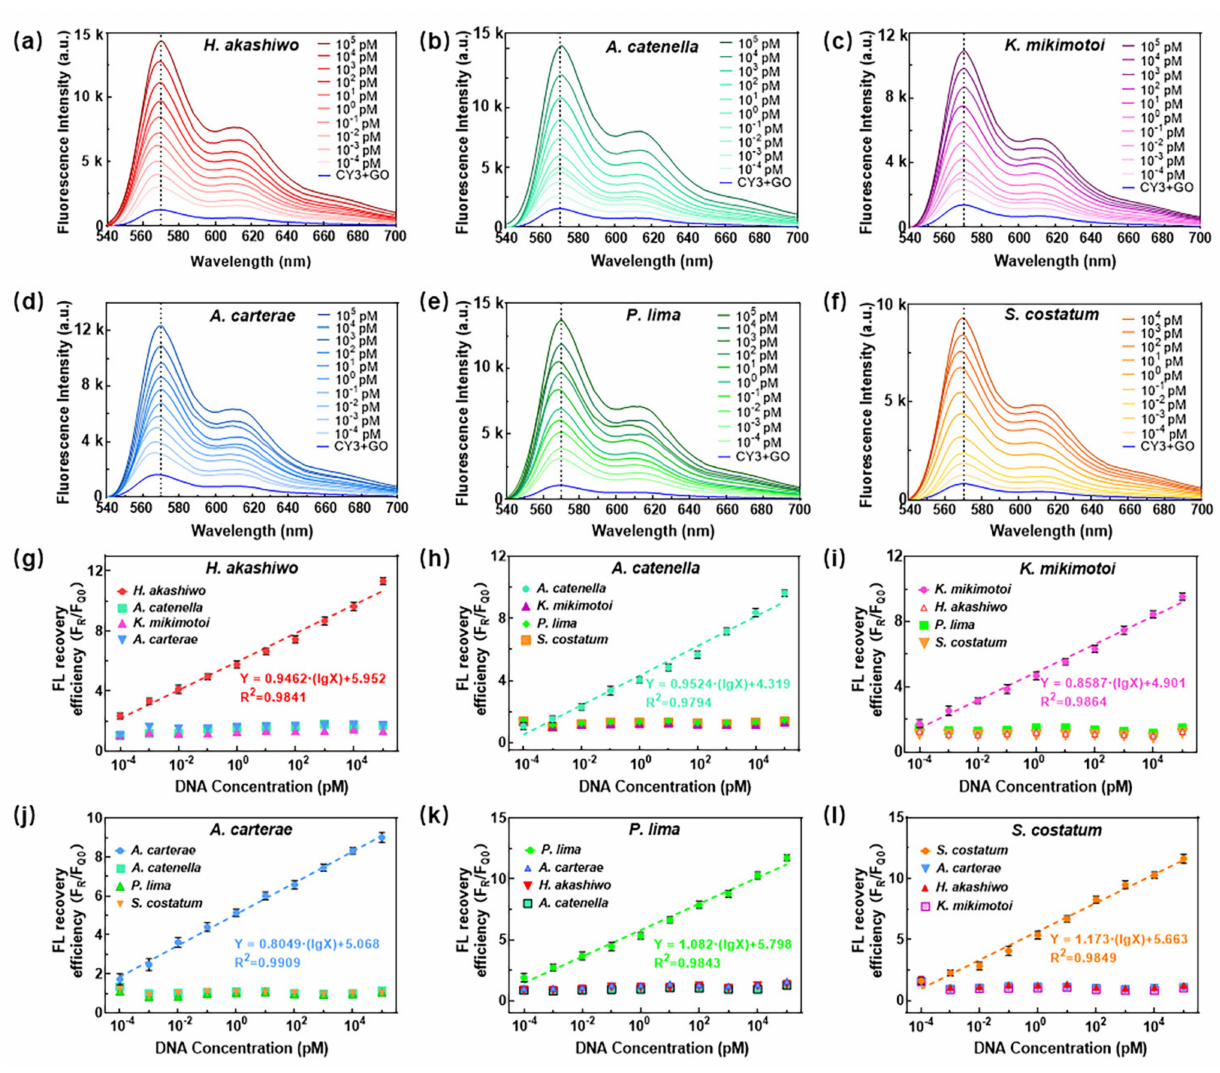
Figure 4. ( a – f ) PL spectrum of 18S rDNA gene of six algae with different concentrations. ( g – l ) Fluorescence recovery efficiency dependence on concentration of 18S rDNA gene of six